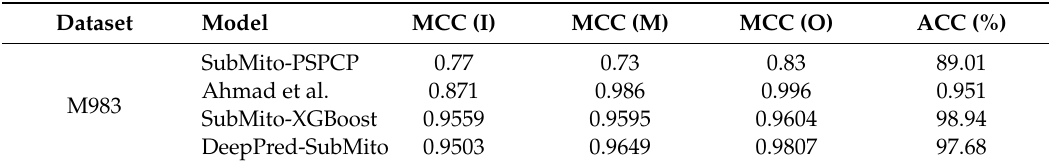
Table 4. Prediction results for submitochondrial of the M983